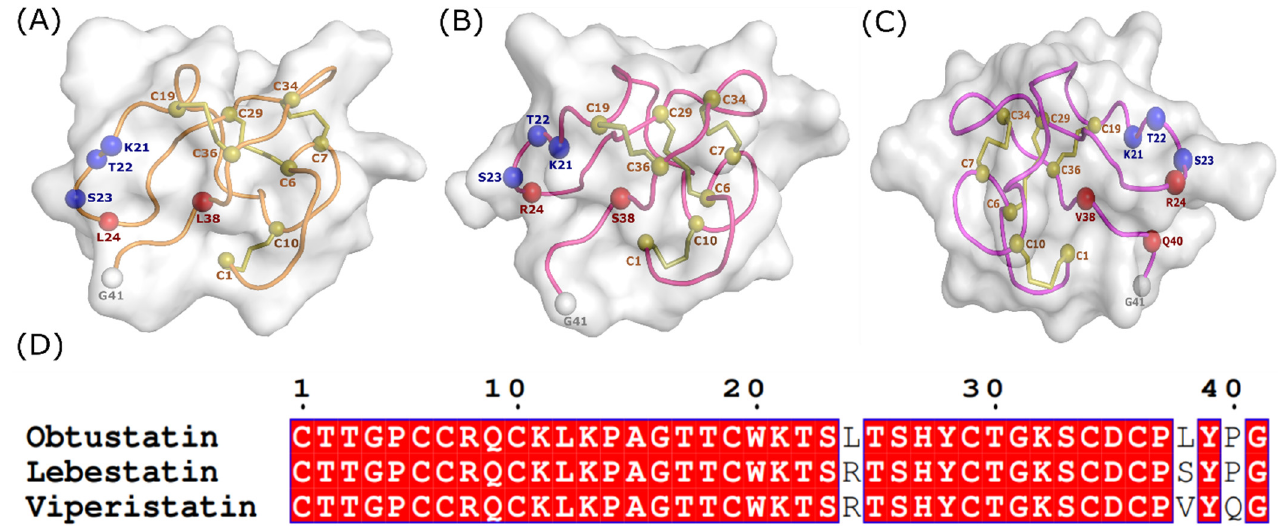
Figure 3. Homology modeling of KTS-disintegrin. KTS motif represented in blue, the disulfide bridge (Cn) stained in olive, the C-terminus (G41) colored in white and all mutations colored in red. ( A ) Obtustatin NMR structure (code PDB 1MPZ); ( B ) 3D structure of Lebestatin; ( C ) Viperistatin generated by homology modeling; and ( D ) multiple alignment sequences of the KTS-disintegrins family.